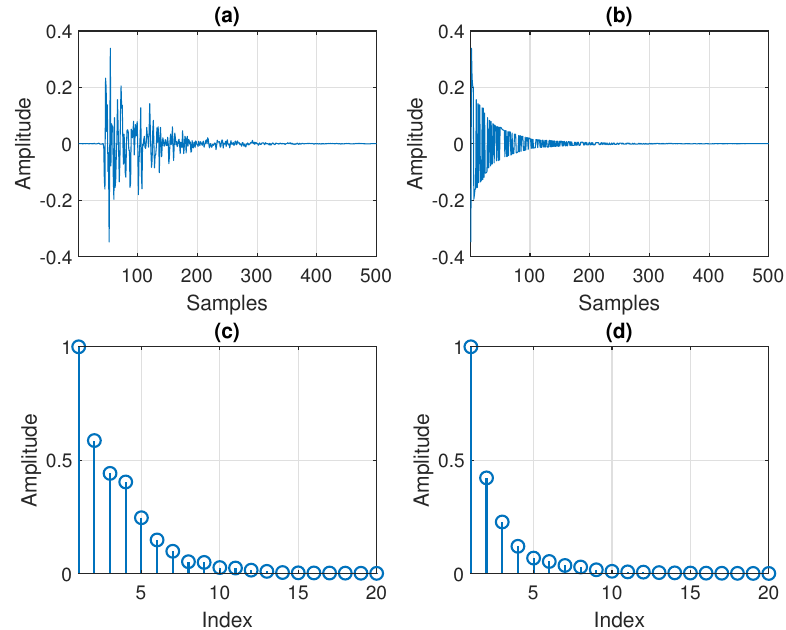
Figure 17. ( a ) Acoustic impulse response h of length L = 500 (with L 1 = 25 and L 2 = 20); ( b ) resulting impulse response (cid:101) Qh ; ( c ) singular values of the matrix H = ivec ( h ) ; and ( d ) singular values of the (cid:16) (cid:17) matrix (cid:101) H = ivec (cid:101) Qh